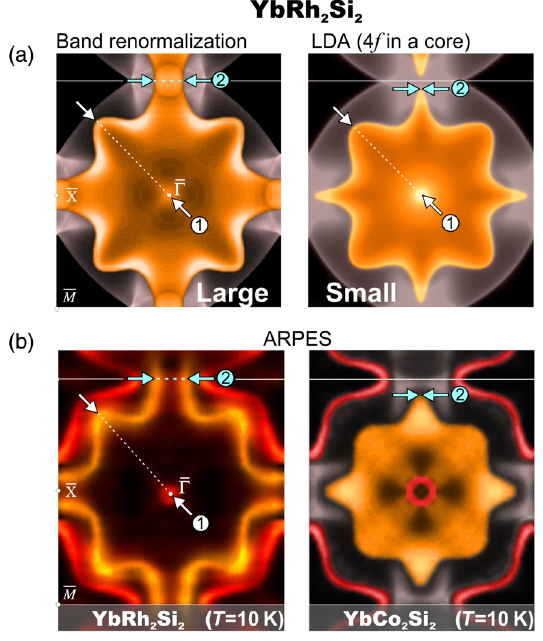
FIG. 2. (a) The large and small FS of YbRh 2 Si 2 calculated within the renormalized band structure approach and the LDA scheme, respectively. (b) FS of YbRh 2 Si 2 ( T K ¼ 25 K) and YbCo 2 Si 2 ( T K < 1 K) as seen in ARPES at T ∼ 10